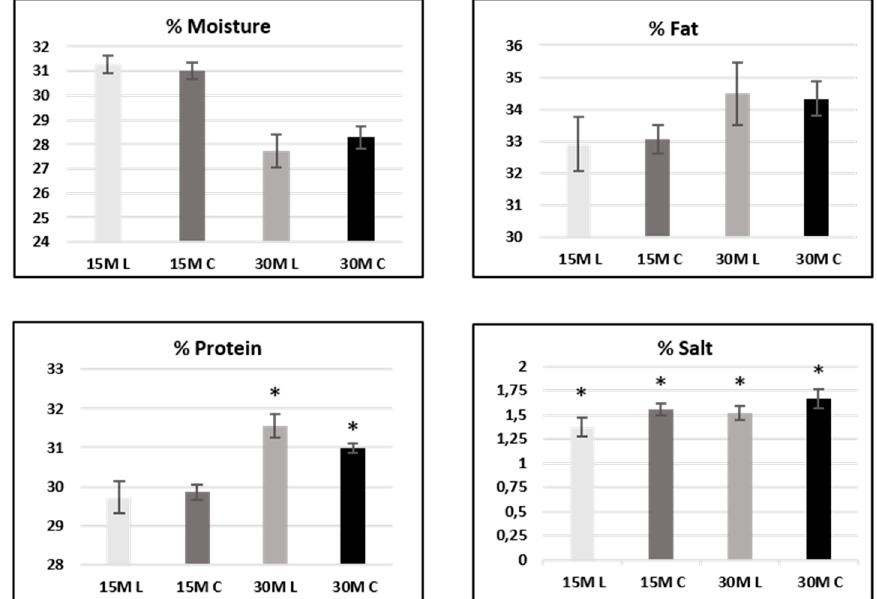
Figure 1. Descriptors from proximate analysis in 15- and 30-month-ripened samples. Values are expressed as the mean ± standard deviation over the samples of each group. Samples are la- beled according to their ripening time (15-month-ripened samples: light -gray and dark-gray bars; 30-month-ripened samples: gray and black bars) and salt content: low-salt samples are labeled L, whereas conventional samples are labeled C. Differences are significant at p < 0.05